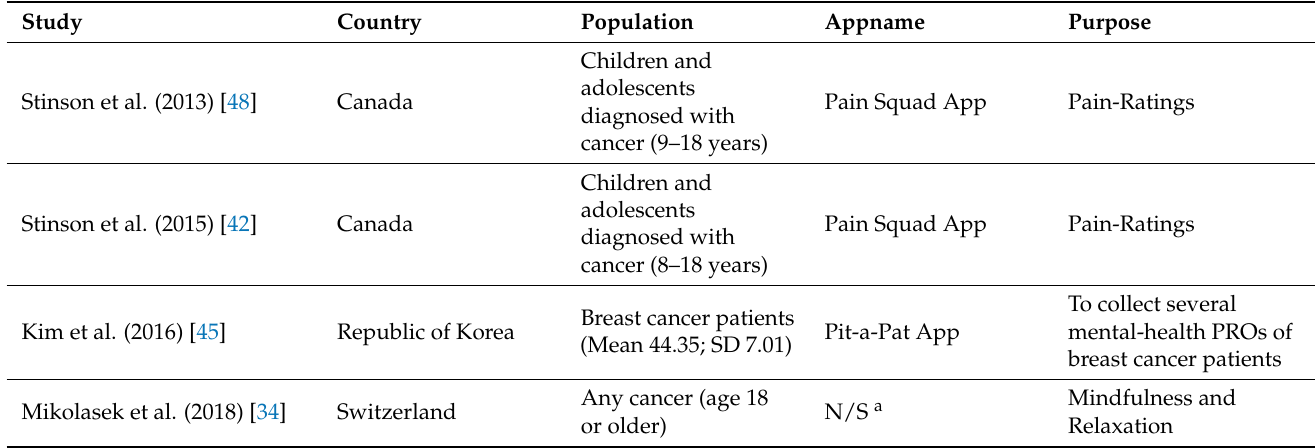
Table 1. Population, intervention and app characteristics of the included studies .